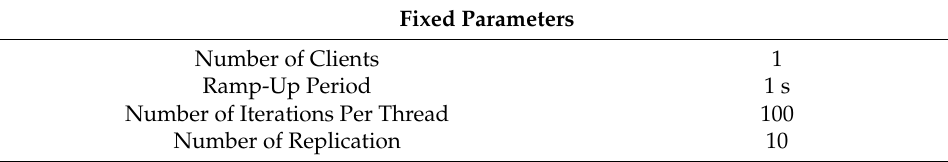
Table 2. Fixed parameters that define all experiments.